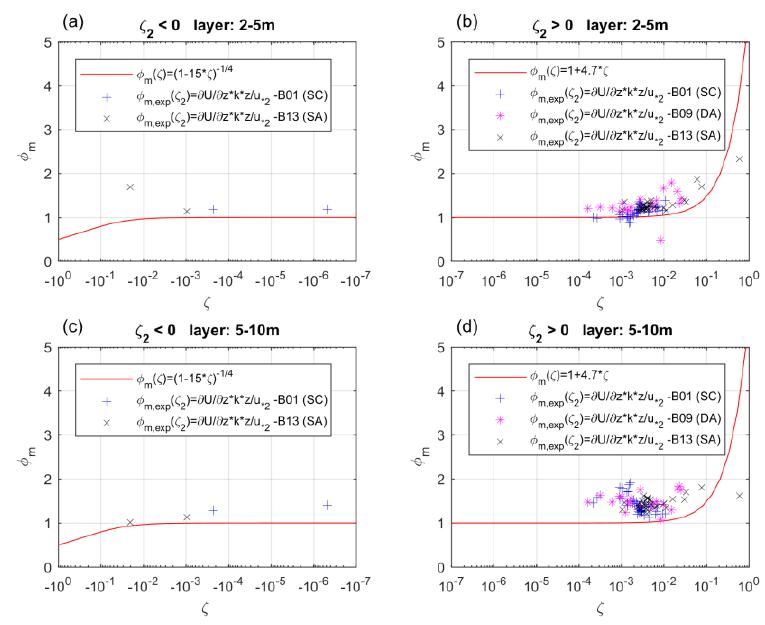
Figure 18. The experimental similarity function values averaged over 30-min intervals. The blue, magenta, and black markers denote the intervals from episode B01, B09, and B13, respectively, compared to the theoretical values of the similarity functions (red lines), for the statically unstable ( a , c ) and stable ( b , d ) surface layer.